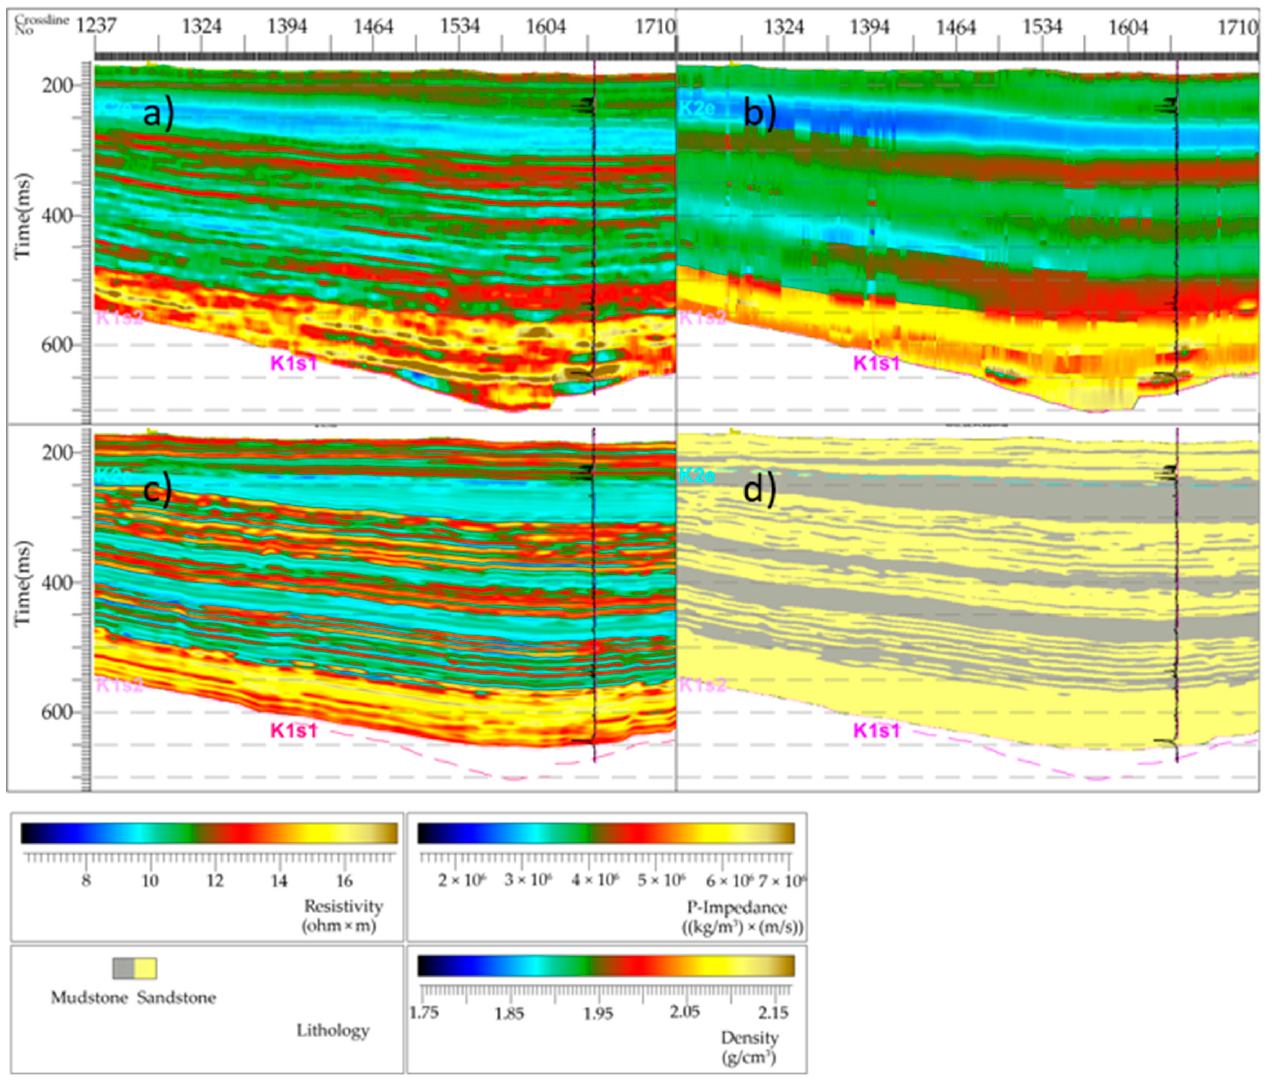
Figure 11. Inversion results of a typical cross-well line; p -wave impedance of target layer calculated by post-stack inversion ( a ), density of target layer calculated by pre-stack inversion ( b ), resistivity of target layer calculated by well loggings inversion method based on the constraint of seismic data ( c ), and lithology transformed by resistivity ( d ); the inserted curves of the four pictures are the